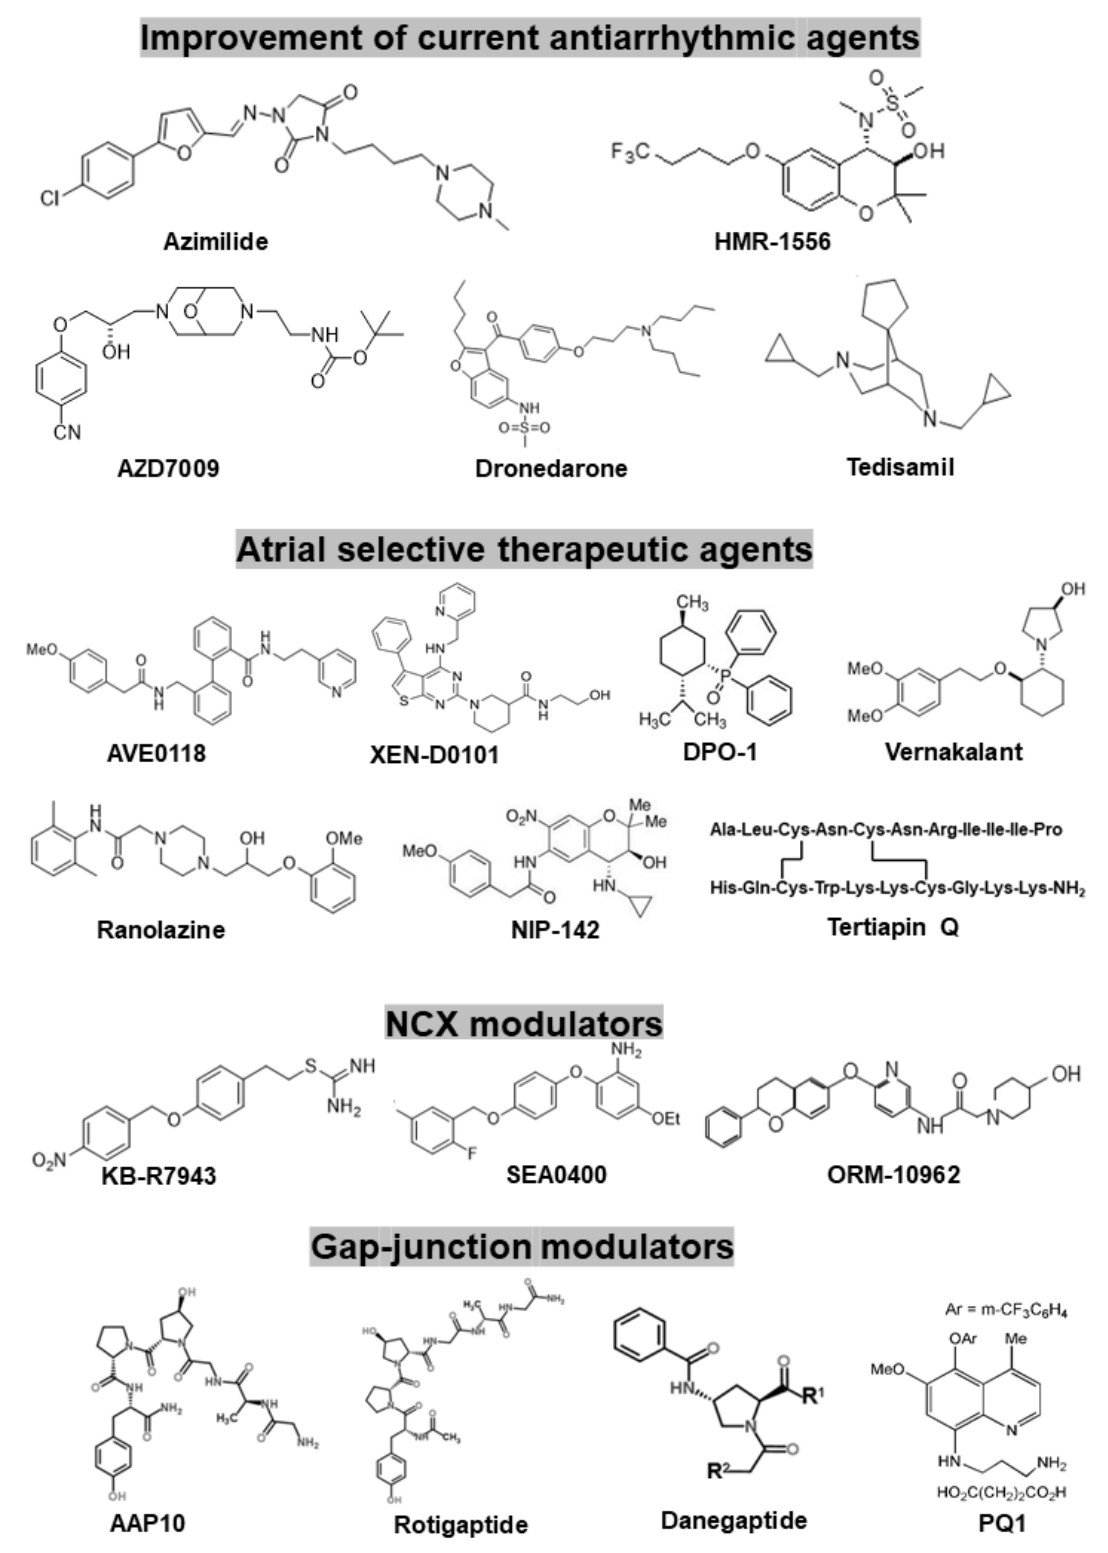
Figure 5. The chemical structures of the reviewed drugs in the present paper (specific-, multiple-, atrial selective ion channel blocker drugs and gap-junction modulator antiarrhythmic peptides.